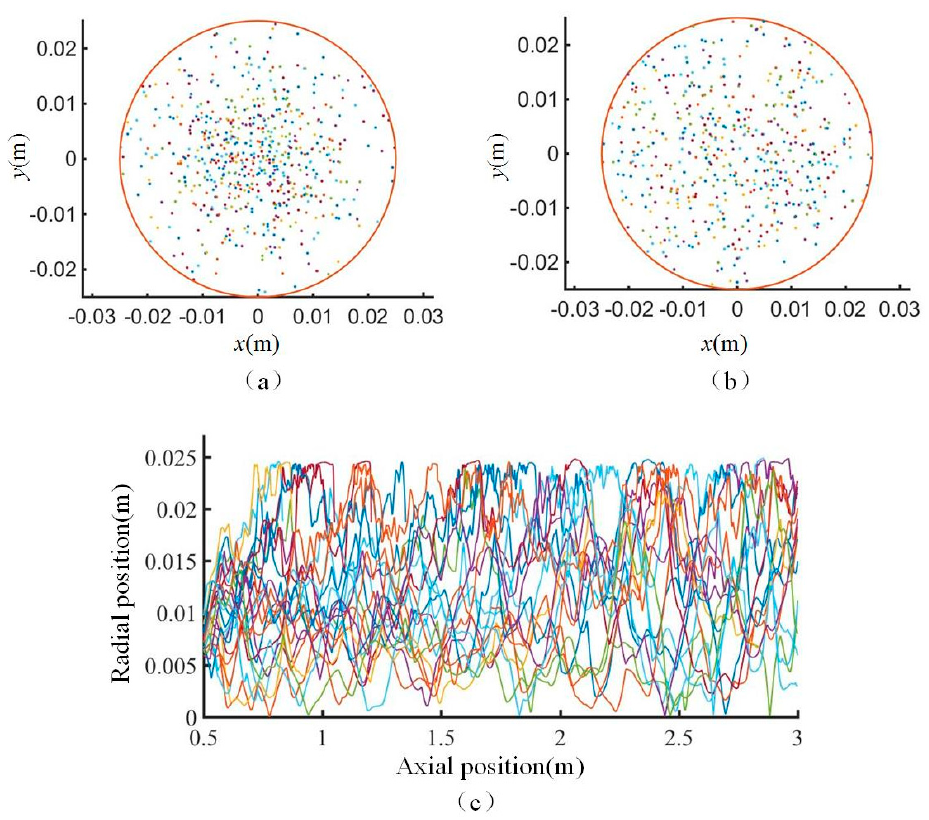
Figure A3. Schematic diagram of particle movement. ( a ) Cross-sectional distribution of particles after 0.5 m movement; ( b ) Cross-sectional distribution of particles after 1.5 m movement; ( c ) Radial positions of particles along the axial direction.